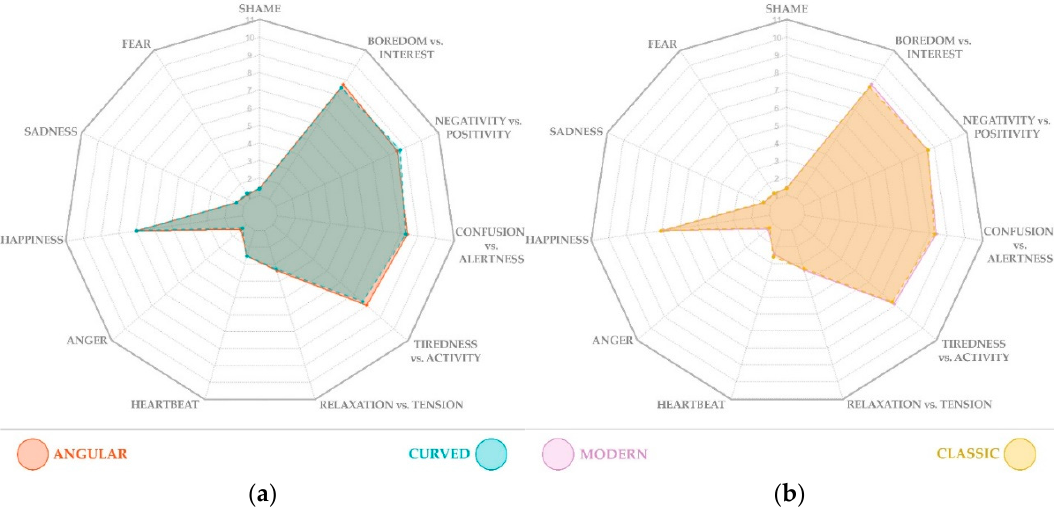
Figure 5. Display of participants’ responses to the momentary affect questionnaire. Emotional feelings and bodily sensation were rated on unipolar scales (0–10), while arousal and valence (tension, activity, positivity) and cognitive (alertness) and motivational (interest) states ratings were presented on bipolar scales ( − 5, 0, 5). Both scales were converted to (1–11) for analysis and display purposes. Individual scores were calculated based on averaging responses to every two rooms presenting the same condition, and the charts’ scores represent means on each of the dimensions. Plot ( a ) displays results for contour conditions (angular vs. curved), and plot ( b ) shows results of style conditions (modern vs. classic). These graphics were created in R Studio, using package fmsb (Minato Nakazawa, 2021, Available on: